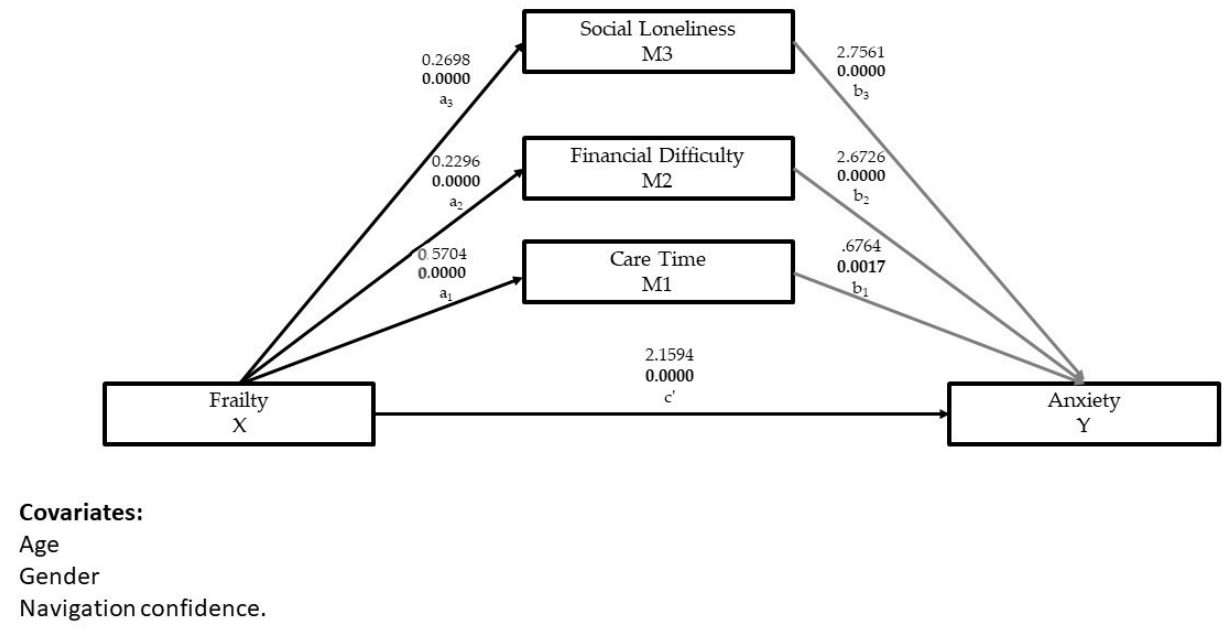
Figure 2. The parallel mediating effects of care time, financial difficulty, and social loneliness in a relationship between frailty and anxiety. Table 3. Testing weekly care work, financial difficulty, and social loneliness as mediators in the relationship between caregiver frailty and anxiety.